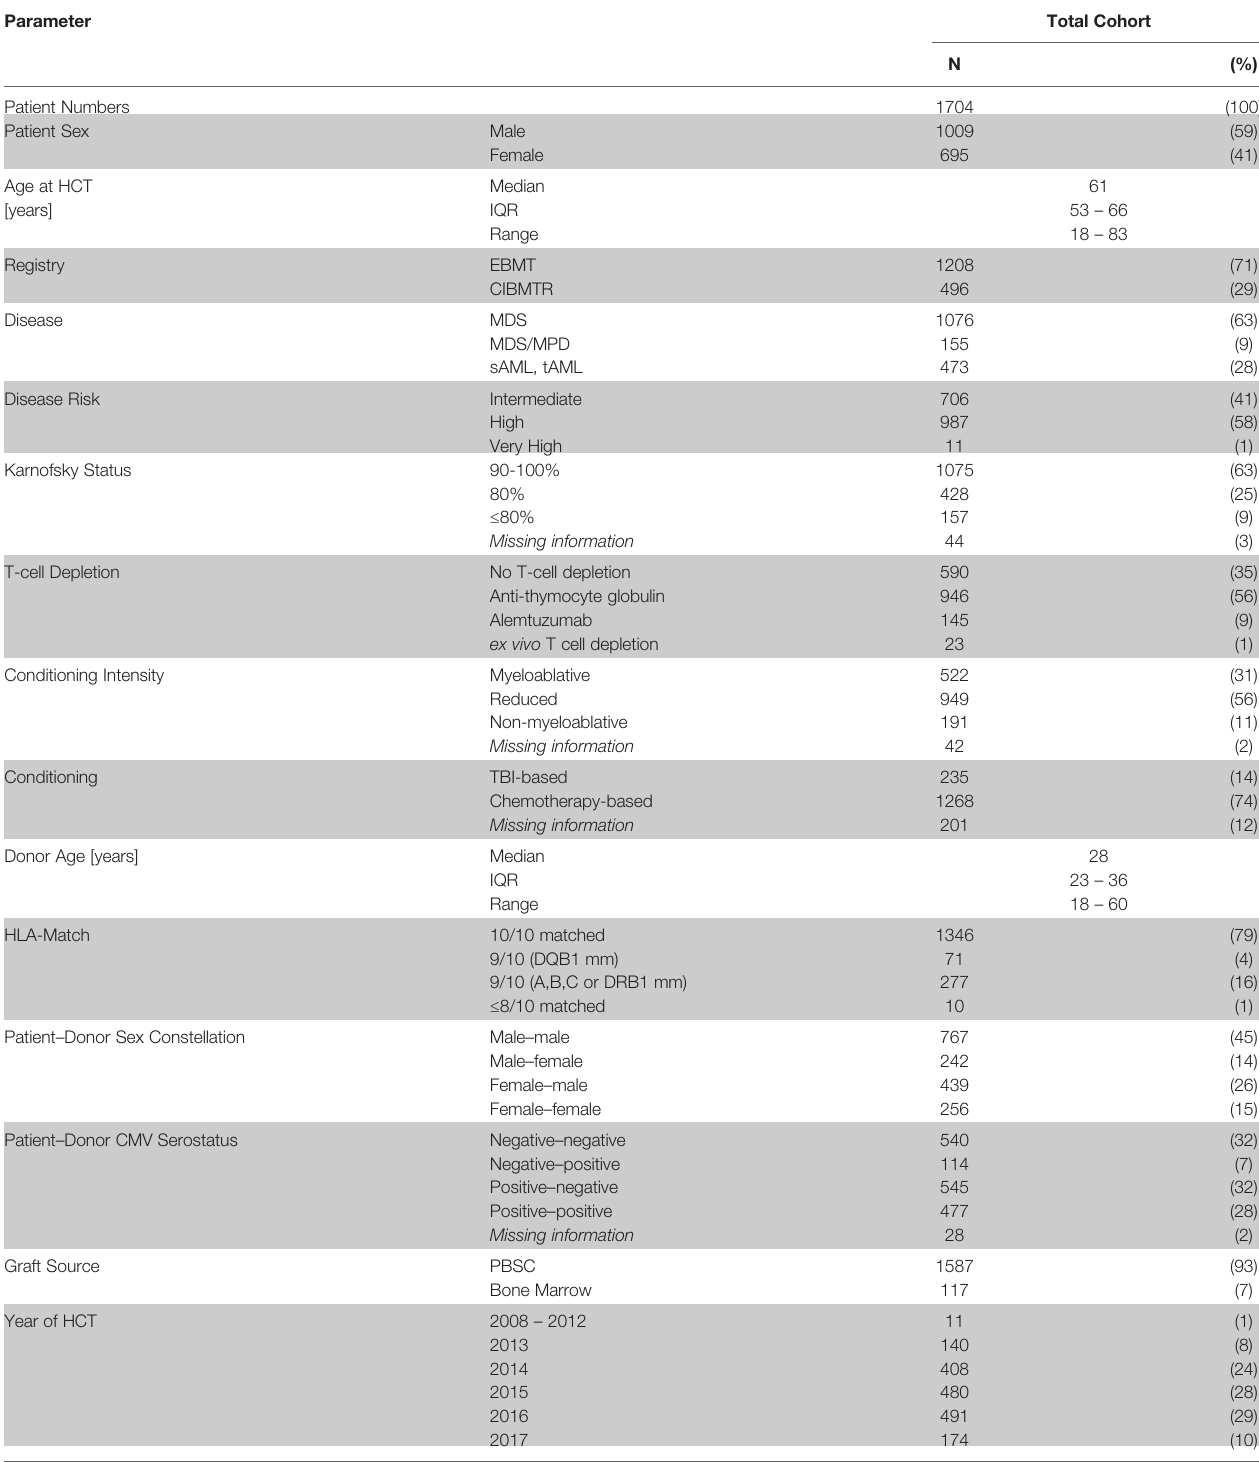
TABLE 1 | Patient and treatment